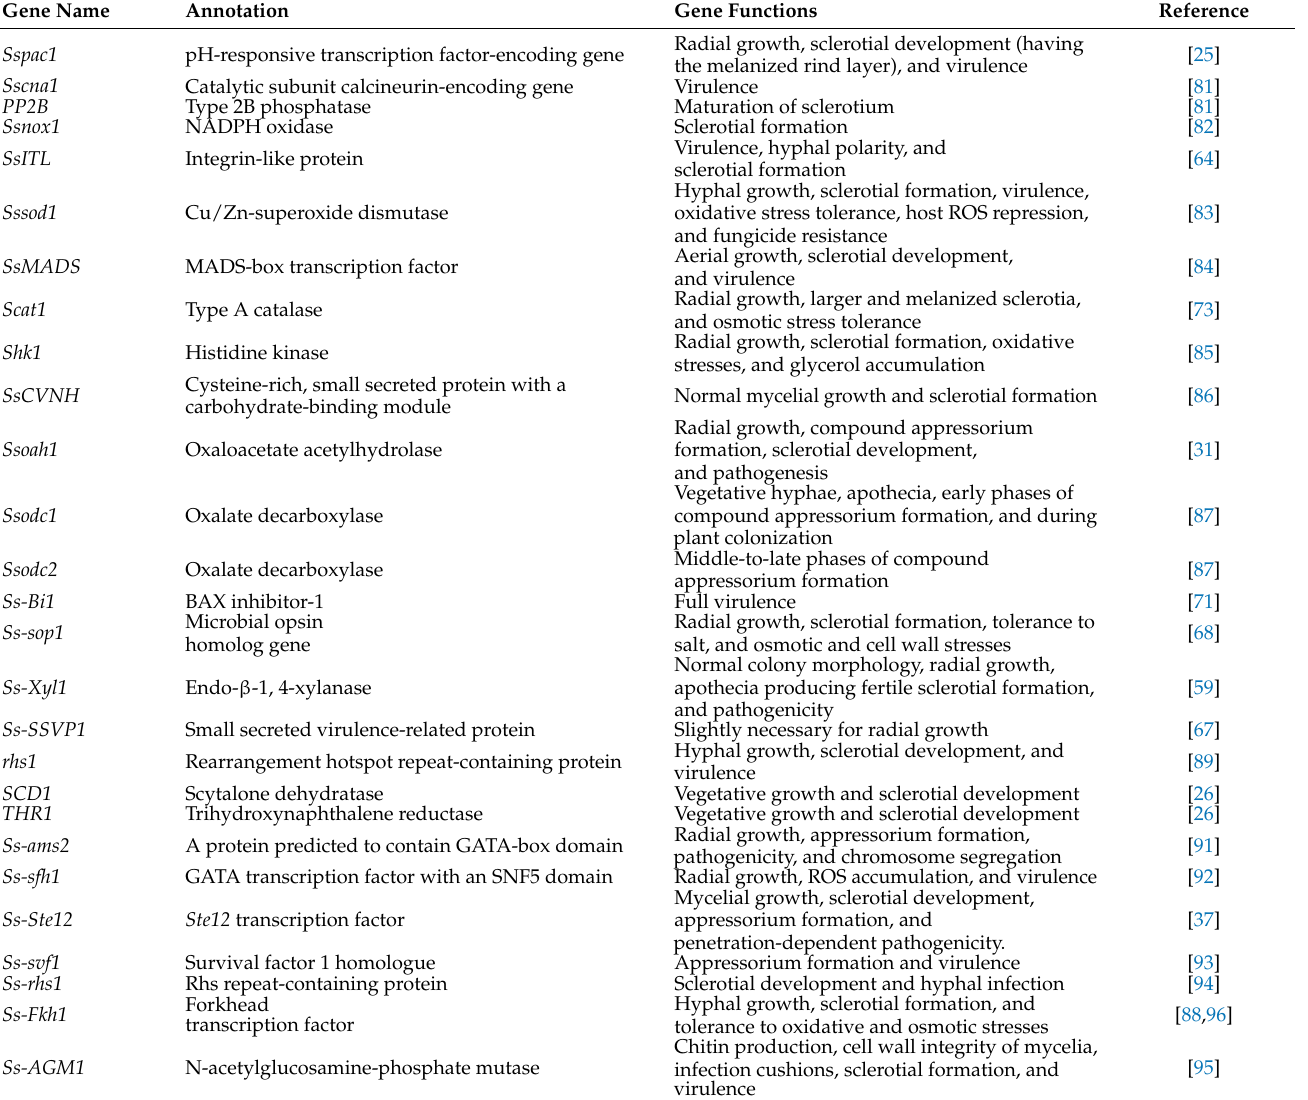
Table 1. List of potential genes regulating growth, development, and virulence of Sclerotinia sclerotiorum